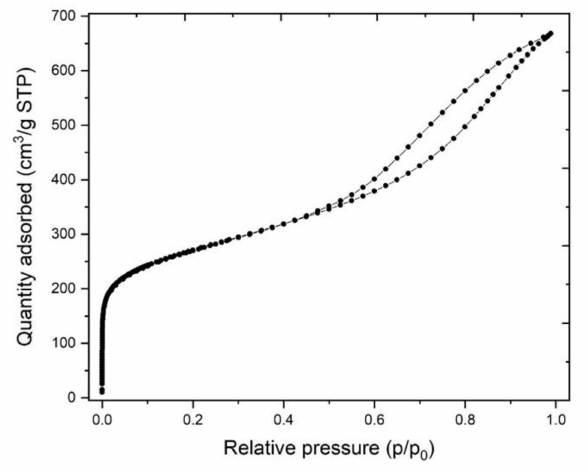
Figure 2. Nitrogen adsorption–desorption isotherms for the obtained AC. Table 1. Composition of the precursor (SCG) and the final AC.